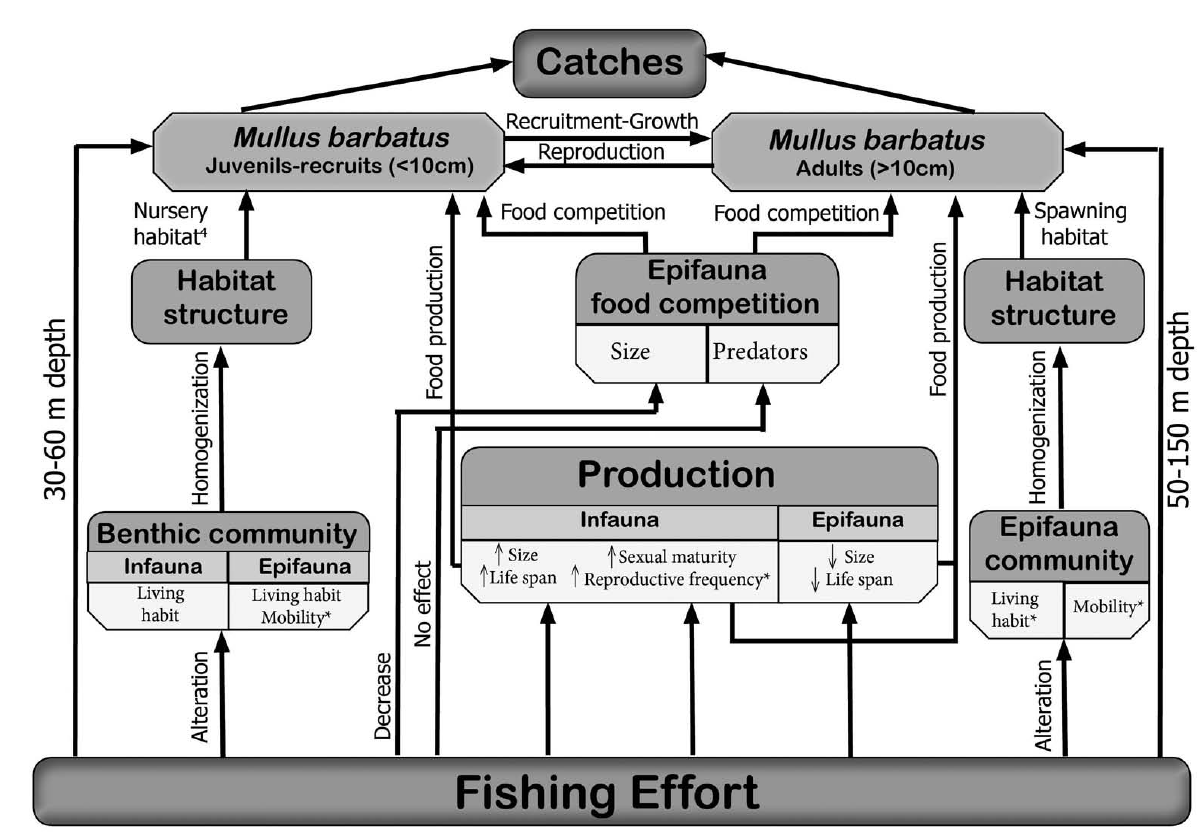
Fig. 7. Complex interactions and main potential effects of changes in benthic community due to trawling on red mullet population. *Traits changing over different fishing effort regimes; the other traits showed differences between fished and control